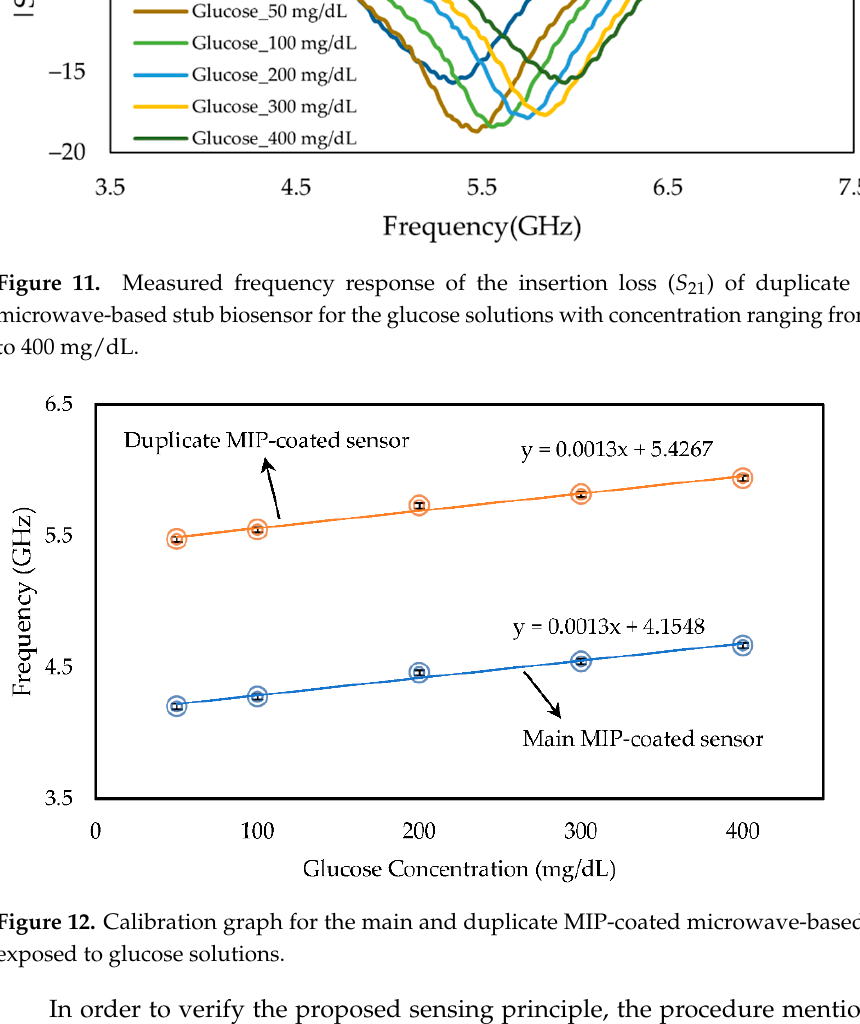
Figure 12. Calibration graph for the main and duplicate MIP-coated microwave-based biosensors exposed to glucose solutions.